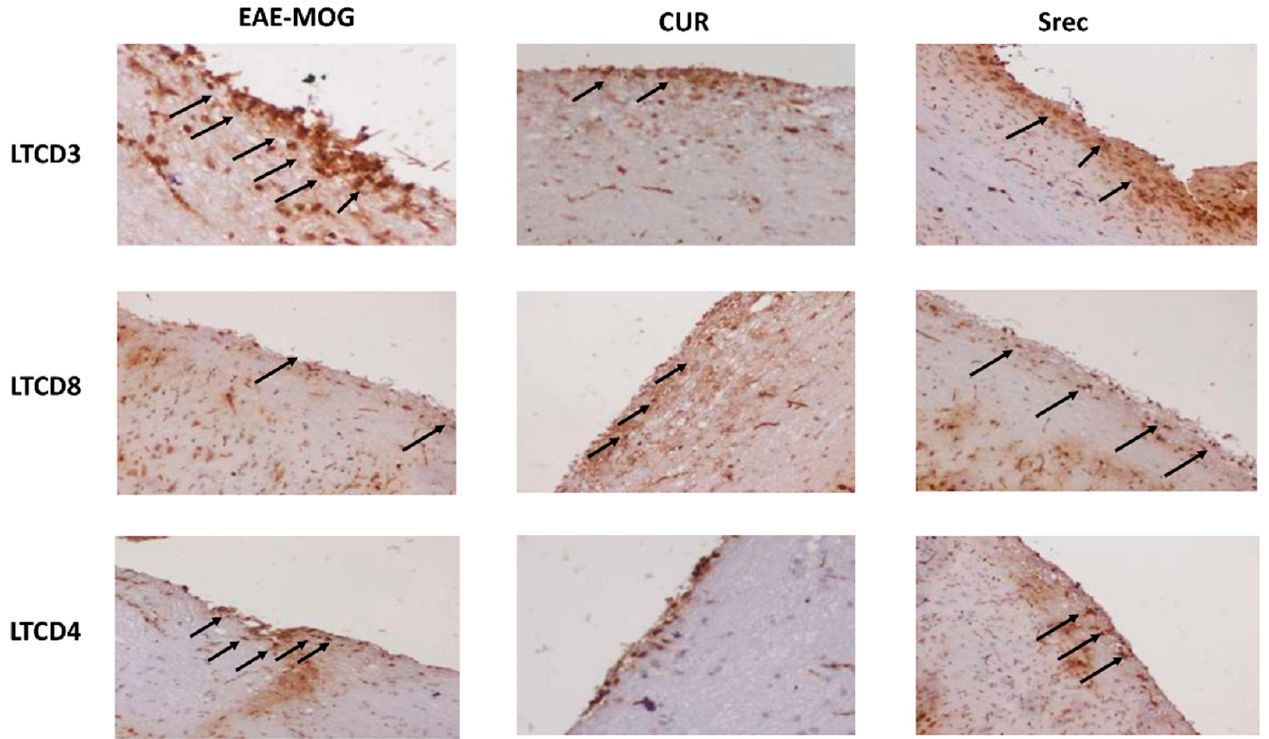
Figure 5. Effect of curcumin on the expression of immune cells in the spinal cord of EAE mice. Immune cell infiltration was studied using immunostaining of mice spinal cords with anti-CD3, CD4 and CD8 antibodies (Obj × 20). Arrows show an increase in the expression of LTCD3 and LTCD4. Cur treatment decreased the expression of inflammatory markers in the EAE lesions; 10 sections from each group were scored.